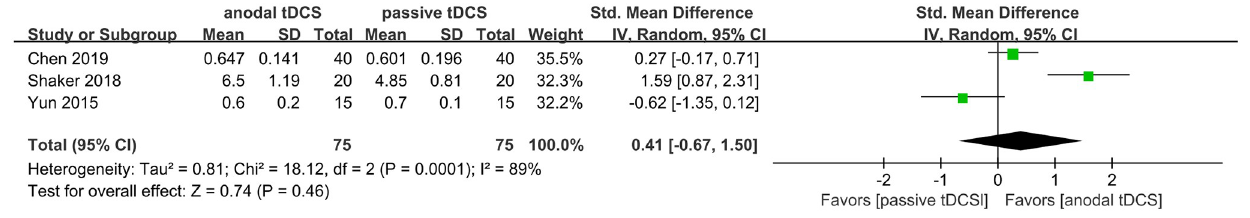
Fig 7. Forest plot of memory